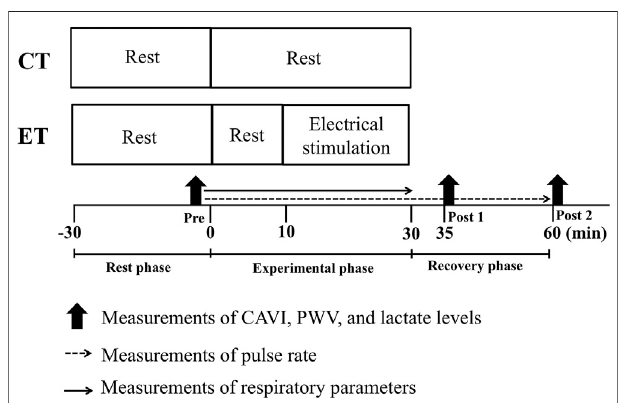
FIGURE 1 | Time course of the experimental protocol. CT, control resting trial; ET, electrical stimulation trial; Pre, pre-experiment; Post 1, 5 min post-experiment; Post 2, 30 min post-experiment; CAVI, cardio-ankle vascular index; PWV, pulse wave velocity. All subjects performed each condition in random order on different